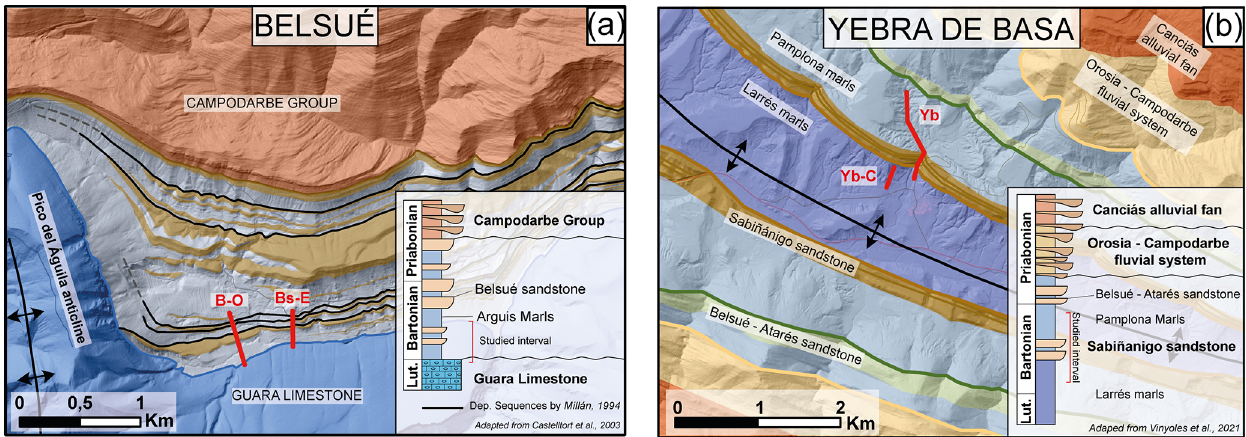
Figure 3. Detailed geological maps from Belsué (a) and Yebra de Basa (b) , modified respectively from Puigdefàbregas (1975) and Boya (2018). Red lines show the location of the studied sites, and the darker grey lines in Belsué represent the depositional sequences defined by Millán et al. (1994). Small stratigraphic logs on the bottom right represent large-scale synthetic logs with the formation name, which are modified from Vinyoles et al. (2021) for Yebra de Basa and from Castelltort et al. (2003) for